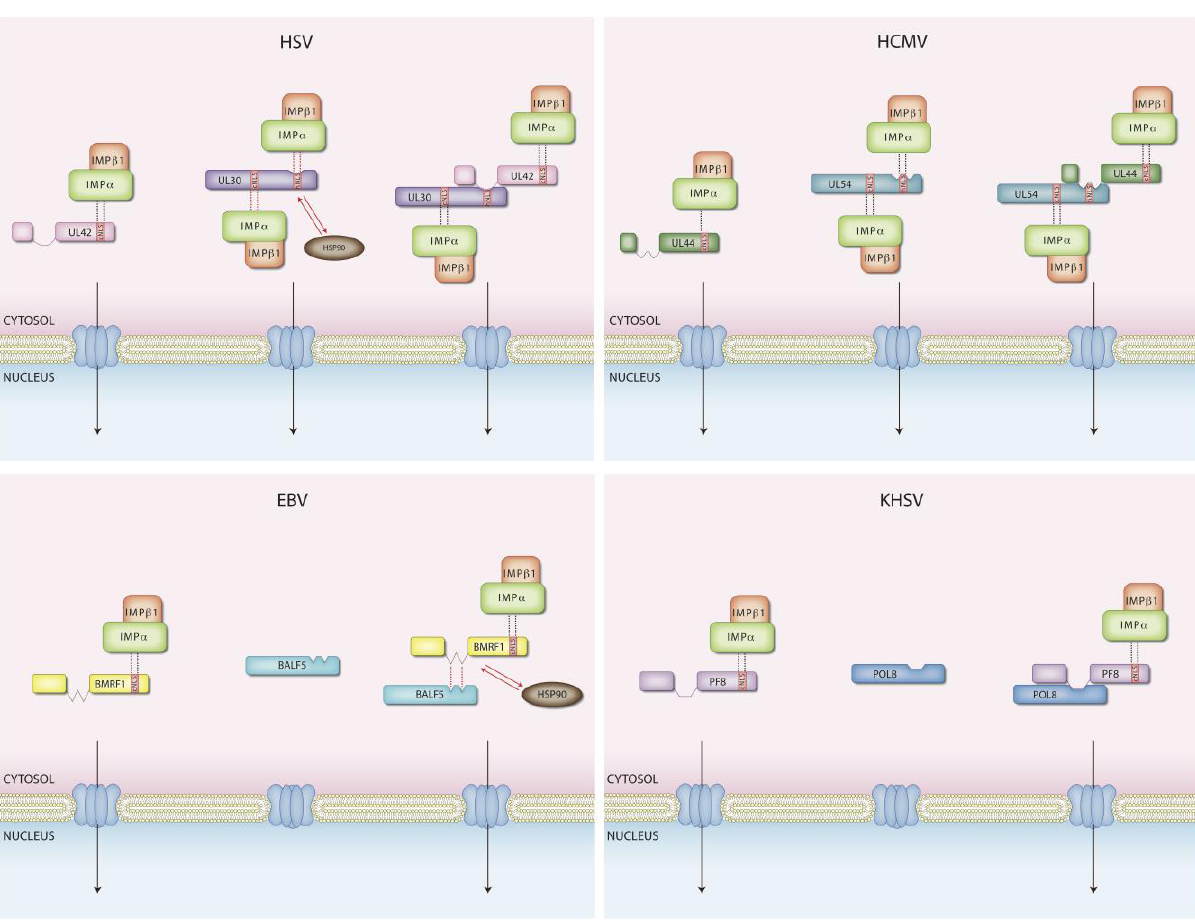
Figure 2. Nuclear transport of DNA polymerase holoenzymes. Different herpesviruses have evolved distinct mechanisms to mediate nuclear targeting of their DNA polymerase holoenzymes. In the case of HSV-1 and HCMV both pol and PAP enzymes possess intrinsic, NLSs and can be imported to the nucleus either alone or as a fully assembled enzyme. In contrast, EBV and KSHV pols are incapable of nuclear targeting in the absence of the respective PAPs, bearing a C -terminally located NLS. A requirement of Hsp90 activity has also been reported for the nuclear import of HSV-1 and EBV pol. Black vertical bars indicate direct protein-protein interactions; red vertical bars indicate direct protein-protein interactions depending on Hsp90